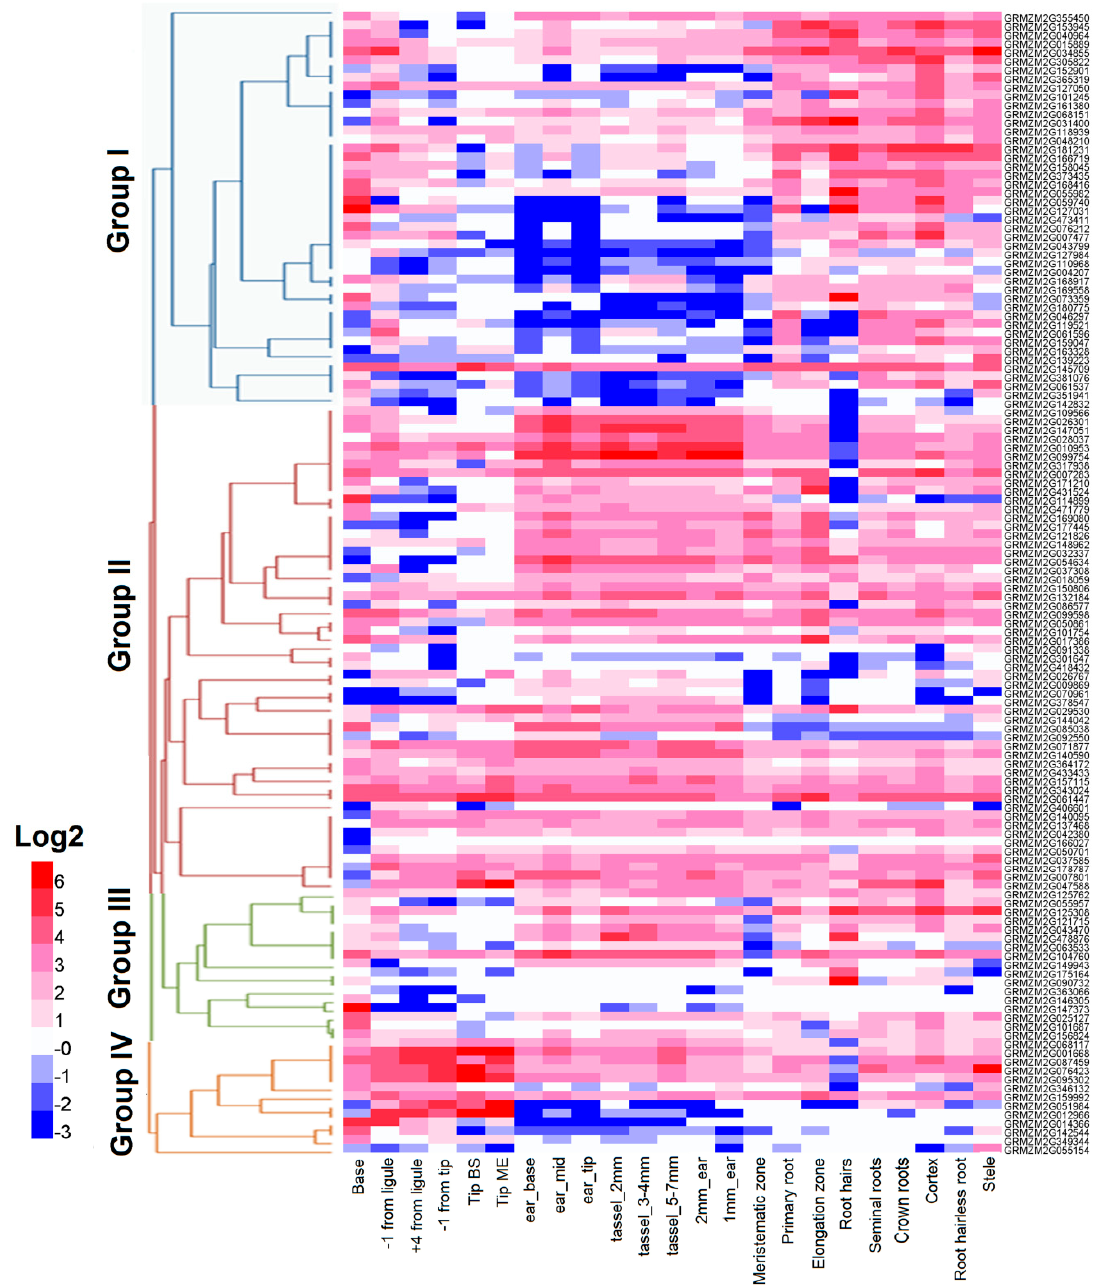
Figure 5. Maize RLCK gene hierarchial clustering. On the left, the color scale indicates the log2 values and the hierarchial clustering displays four expression patterns marked by different colors. The different development periods of leaf, root, ear, and tassel in maize are showed on the bottom.